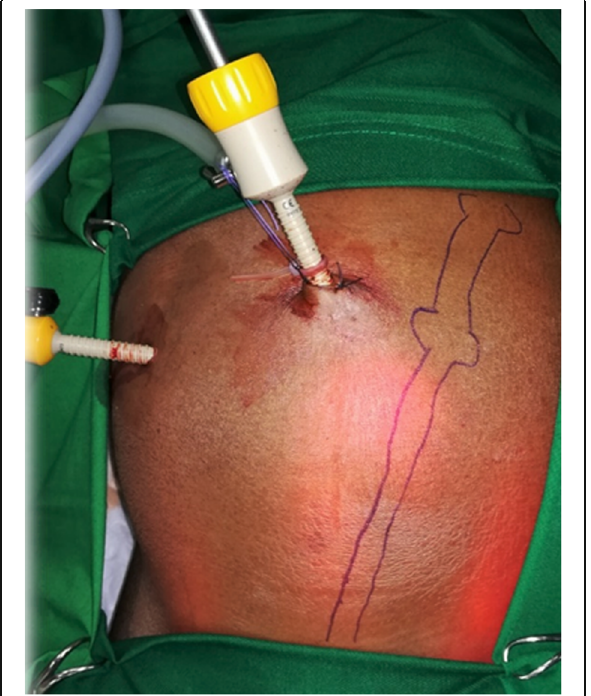
Fig 2 Port position and catheter assumed